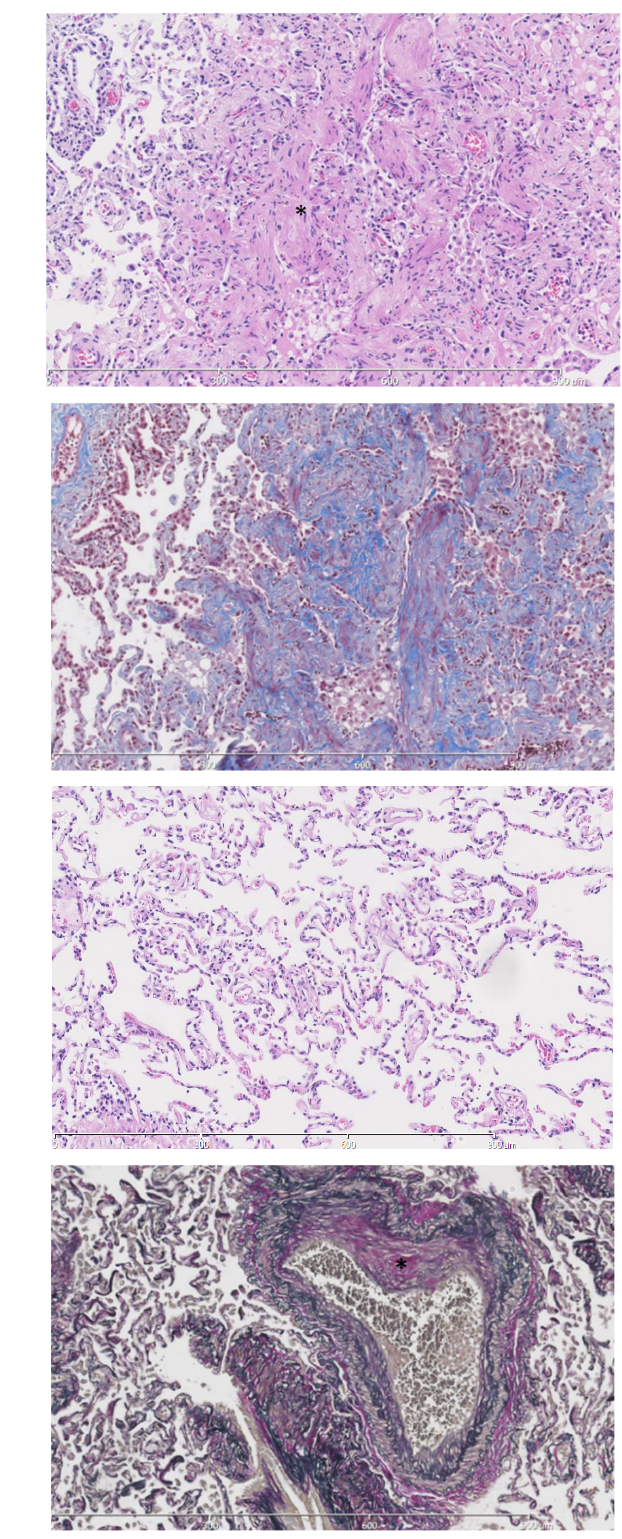
Figure 4. Histopathologic slides of the lung. ( a ). Lung parenchyma showing a probable history of organizing pneumonia with progression towards fibrosis (*). ( b ). Fibrotic areas staining blue in a Masson trichome stain. ( c ). Normal lung from the same patient parenchyma for comparison. ( d ). Elastic van Gieson stain showing an artery with irregular intimal fibrosis (*) No signs of thrombosis or recanalization are seen.